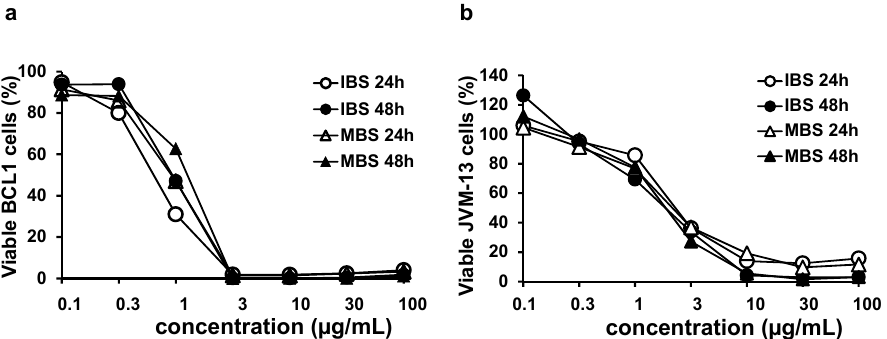
Figure 1. Dose- and time-dependent cytotoxicity of isobutyrylshikonin (IBS) and α -methylbutyrylshikonin (MBS) on the BCL1 cell line. Graphs of ( a ) BCL1 and ( b ) JVM-13 cells’ survival after 24 and 48 h growth in the presence of IBS and MBS determined by MTT assay. All data are presented as mean values from three independent experiments performed in